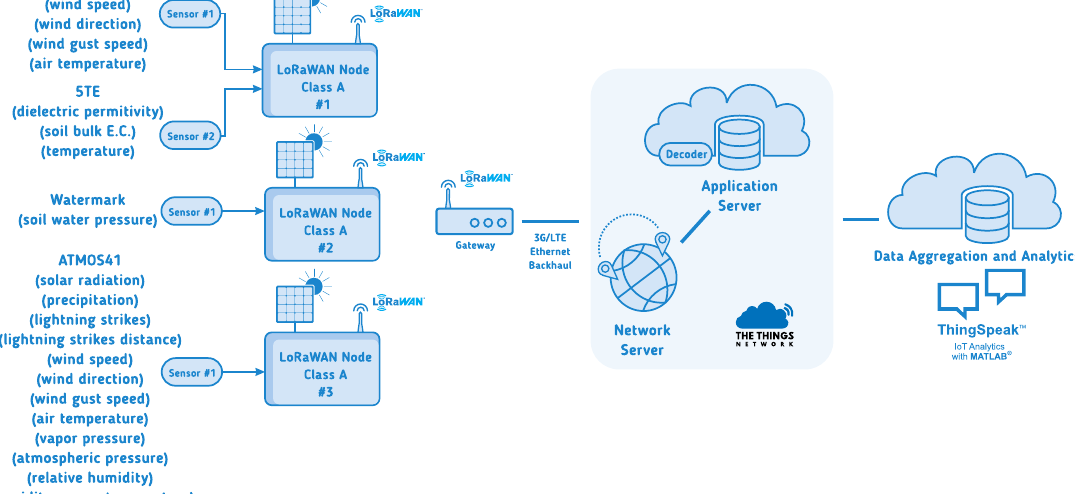
Figure 1. Overview of the implemented system